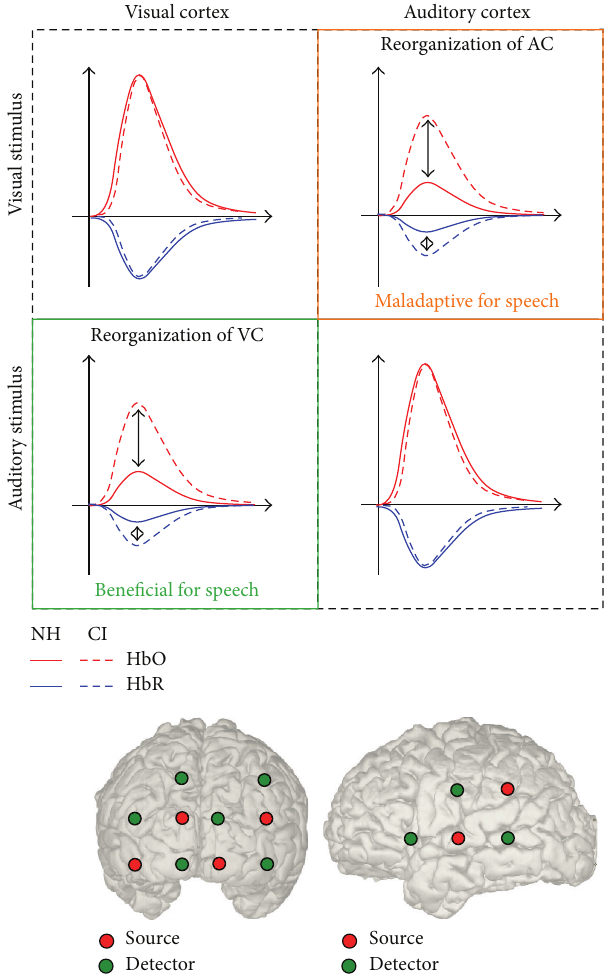
Figure 1: Hypothesis. The upper row represents visual stimuli and the middle row represents auditory stimuli. The left column represents measurement over visual cortex and the right column represents measurement over auditory cortex. The solid lines represent NH controls and the dashed lines represent CI users. We hypothesized observations on reorganization of both visual and auditory cortex. Reorganization of auditory cortex (upper right) is defined as the higher amount of visual-evoked activation in auditory cortex observed in CI users compared to NH controls, which has been shown to be maladaptive in terms of speech performance for CI users. Reorganization of visual cortex (lower left) is defined as the higher amount of auditory-evoked activation in visual cortex observed in CI users compared to NH controls, which has been shown to be beneficial for CI speech performance. The bottom row shows the source and detector positions mapping to the cortex using a 3D digitizer on single